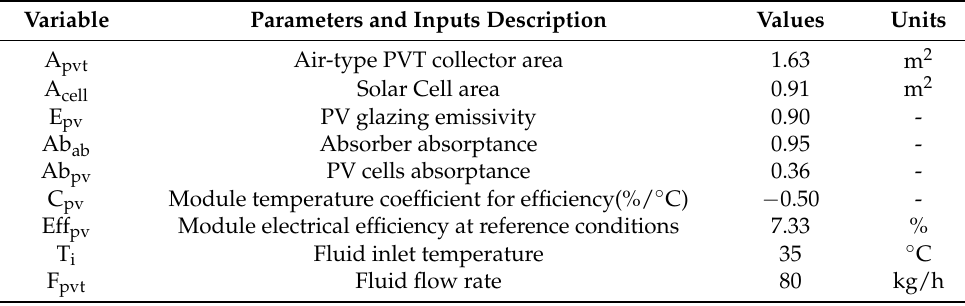
Table 2. Parameters of Type 203 component for TRNSYS